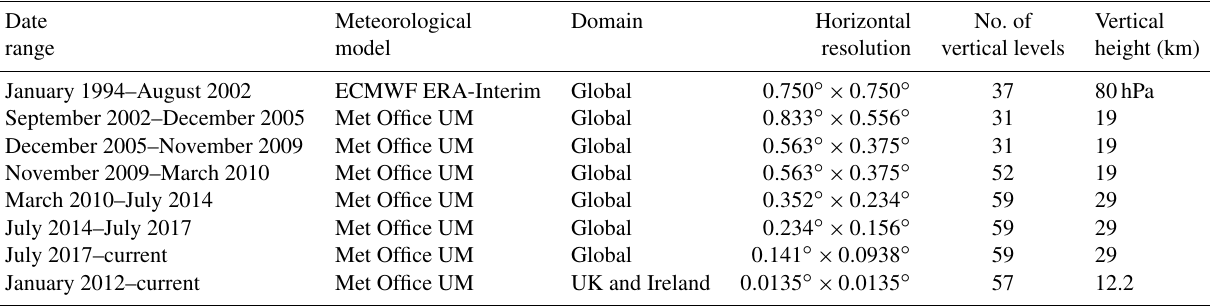
Table 1. Resolutions of the meteorological models used by NAME. The high-resolution model over the UK and Ireland is nested within the available global model both horizontally and vertically.